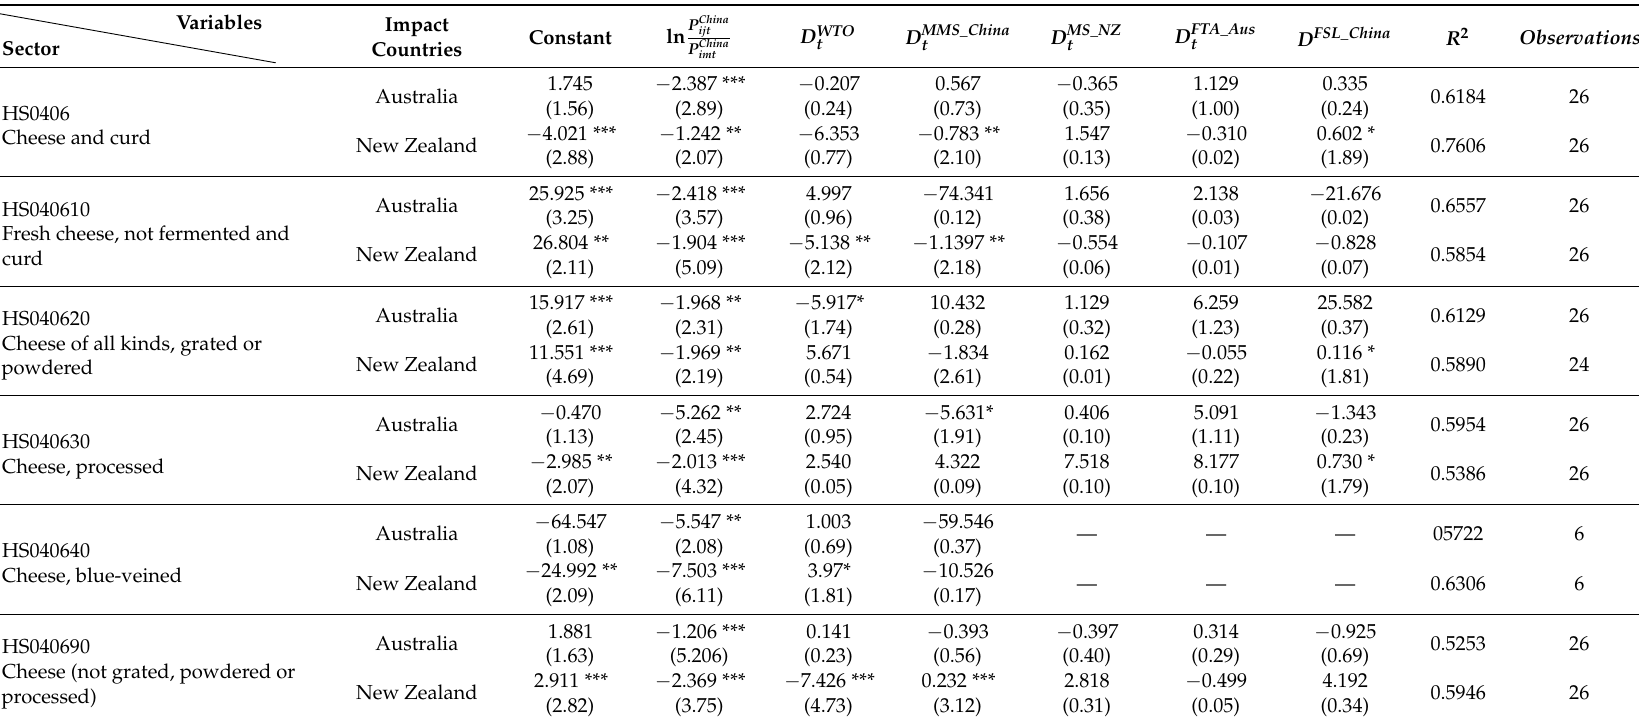
Table 13. Impact of Australia and New Zealand Dairy Products on China imports at Sector HS0406 Using the SUR Model.